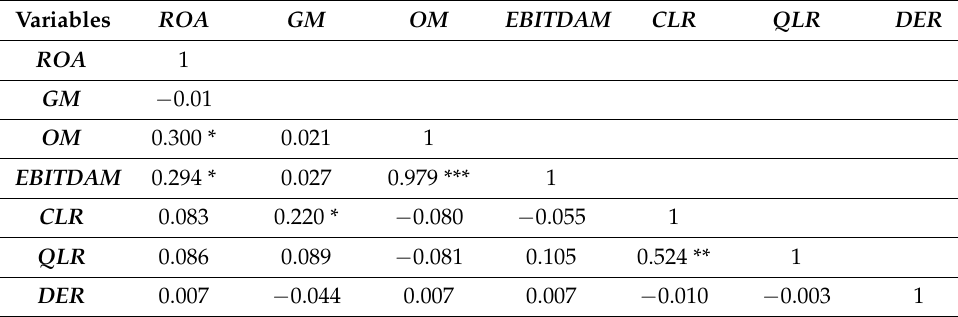
Table 2. Correlation matrix.